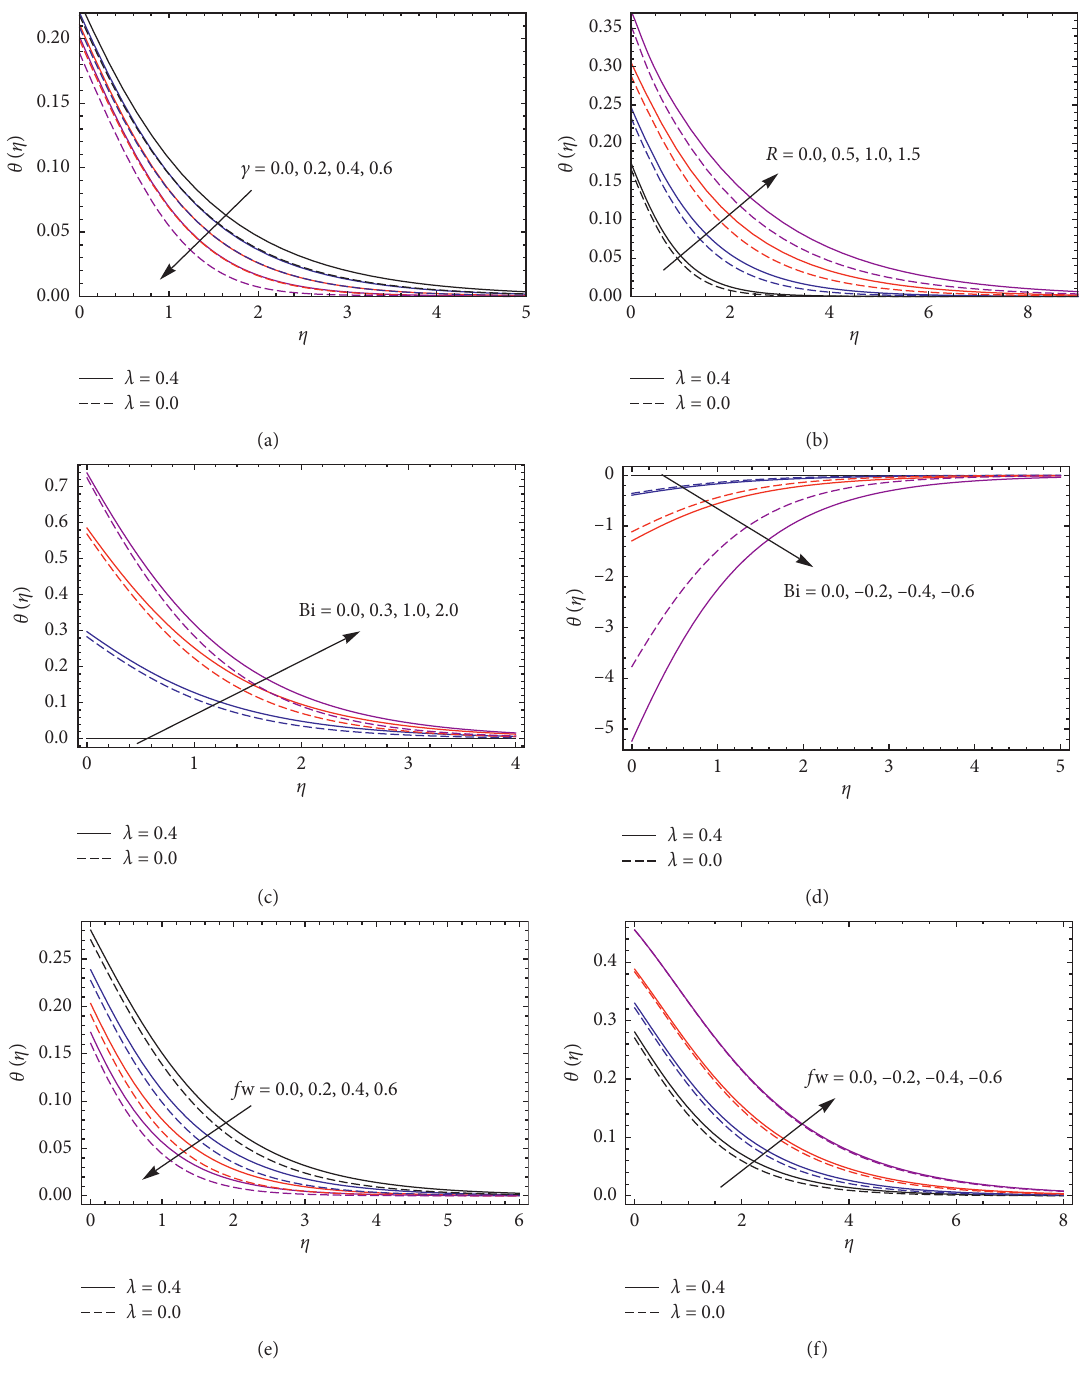
Figure 4: Impact of temperature on the different values of parameters. (a) c � 0 . 0 , 0 . 2 , 0 . 4 , 0 . 6, (b) R � 0 . 0 , 0 . 5 , 1 . 0 , 1 . 5, (c) Bi � 0 . 0 , 0 . 3 , 1 . 0 , 2 . 0, (d) Bi � 0 . 0 , − 0 . 2 , − 0 . 4 , − 0 . 6, (e) fw � 0 . 0 , 0 . 2 , 0 . 4 , 0 . 6, and (f) fw � 0 . 0 , − 0 . 2 , − 0 . 4 , − 0 .